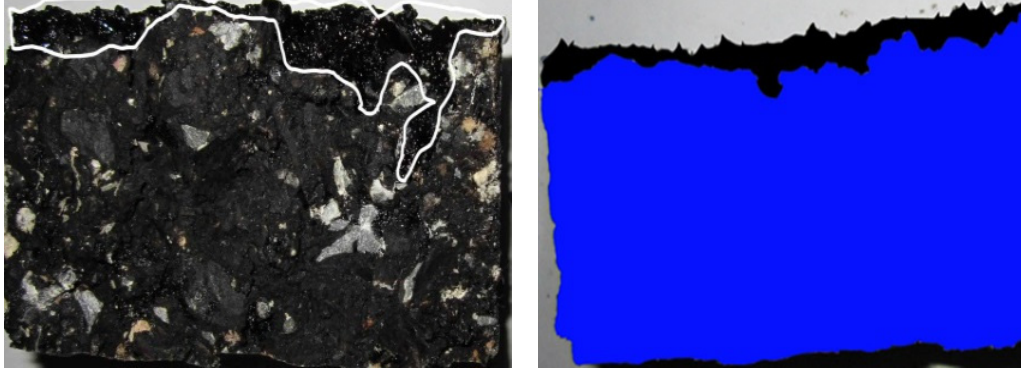
Figure 6. Infiltration interface and digital image analysis.